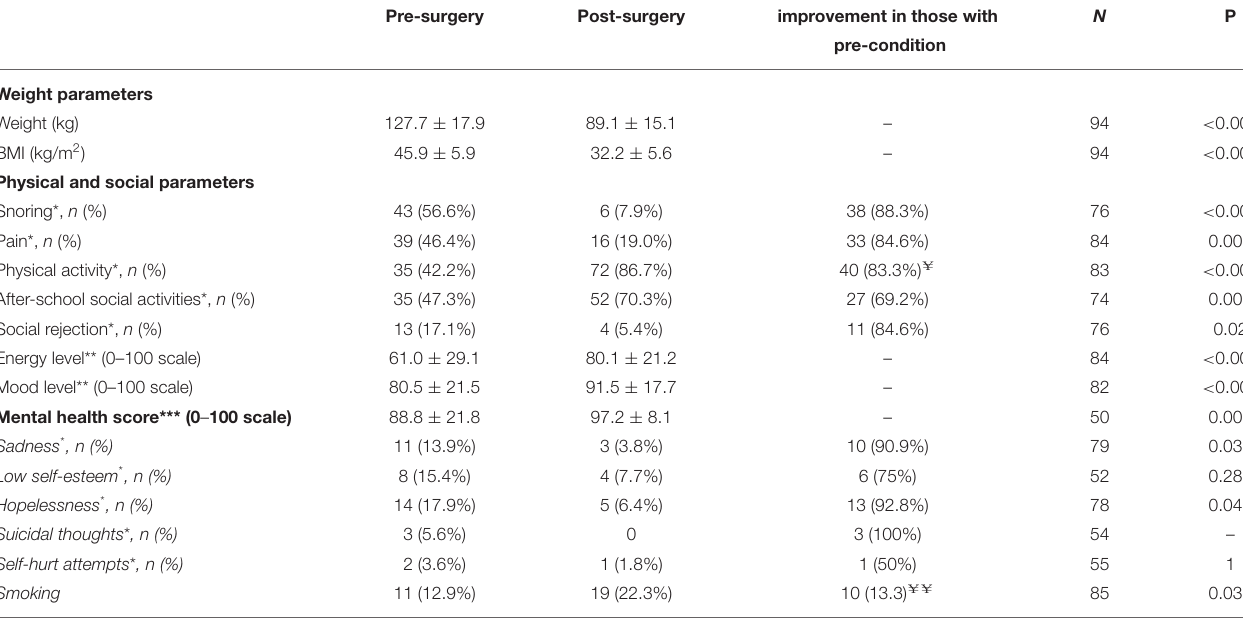
TABLE 2 | Changes in body weight and physical, social and mental parameters 9 months after metabolic bariatric surgery in adolescents. Pre-surgery Post-surgery improvement in those with N P